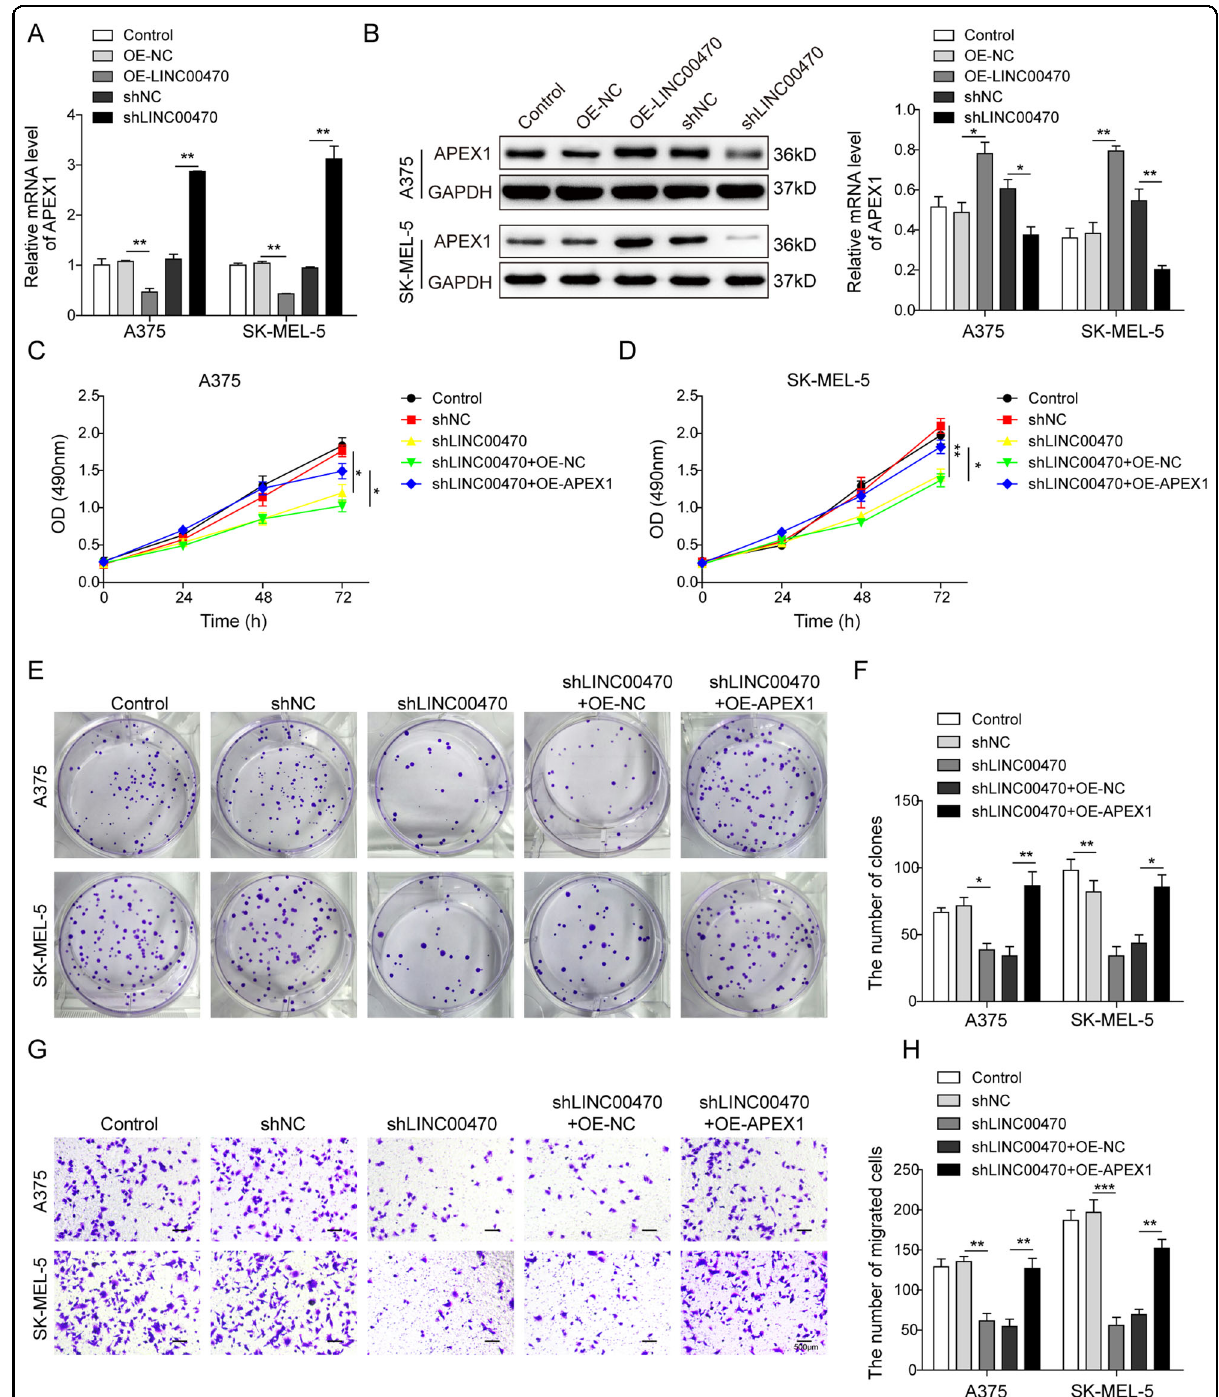
Fig. 4 Proliferation and migration of melanoma cells was promoted by LINC00470 through enhancing APEX1. A qRT-PCR analysis of APEX1 in cells transfected with OE-NC, OE-LINC00470, shNC, and shLINC00470, respectively. B Western blot analysis of APEX1 in cells transfected with OE-NC, OE-LINC00470, shNC, and shLINC00470, respectively. In the following experiments, all the cells were transfected with fi ve different groups, including control, shNC, shLINC00470, shLINC00470 + OE-NC, and shLINC00470 + OE-APEX1, respectively. C , D The cell proliferation of cells with different treatments analyzed by MTT assay for 24, 48, and 72 h. E , F The colony formation assay of the cells with different treatments. G , H Cell migration ability of cells with different treatments analyzed by transwell assay. The mean ± SD in the graph shows the relative levels from three replicates. *p < 0.05 , ** p <